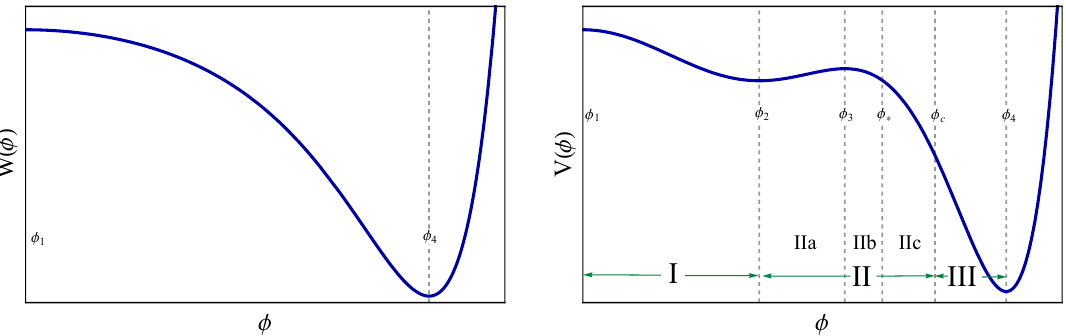
Figure 1 . Qualitative forms of the superpotential (left) and potential (right) of our model. The de(cid:12)nition of the points (cid:30) (cid:3) , (cid:30) c and the di(cid:11)erent regions labelled I, II and III will be explained around eqs. (3.2) and